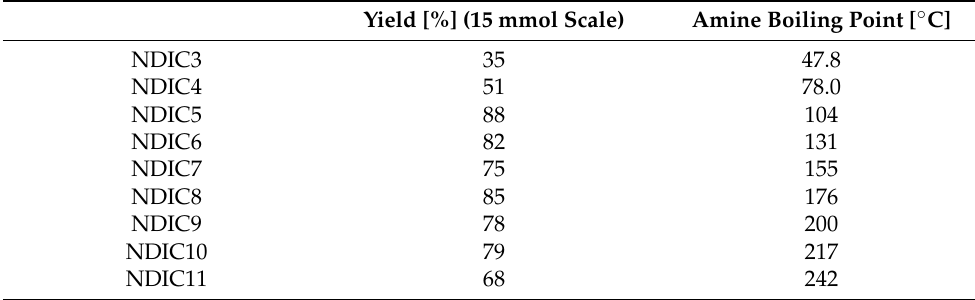
Table 1. Isolated yields of the synthesized